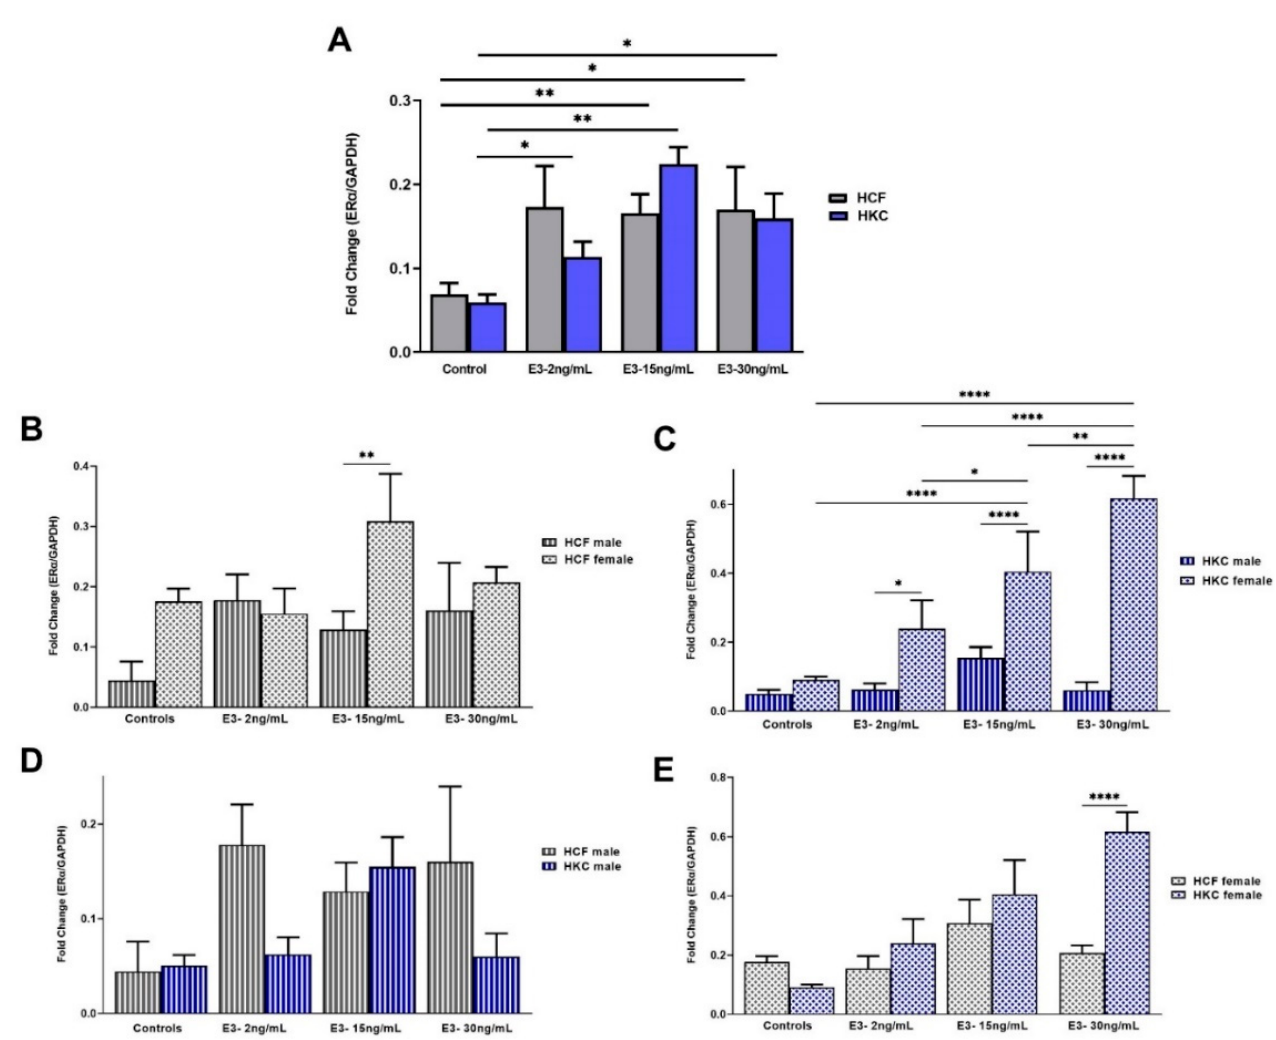
Figure 7. Expression of ER α in 3D HCFs and HKCs in response to 2, 15, 30 ng/mL E3 stimulation for four weeks. ( A ) Overall ER α expression in HCFs and HKCs ( n = 6). ( B ) Sex-specific expression of ER α in HCFs ( n = 3). ( C ) Sex-specific ER α expression in HKCs ( n = 3). ( D ) Male-specific ER α expression in HCFs vs. HKCs ( n = 3). ( E ) Female-specific expression of ER α in HCFs vs. HKCs ( n = 3). * p < 0.05, ** p < 0.01, and **** p <